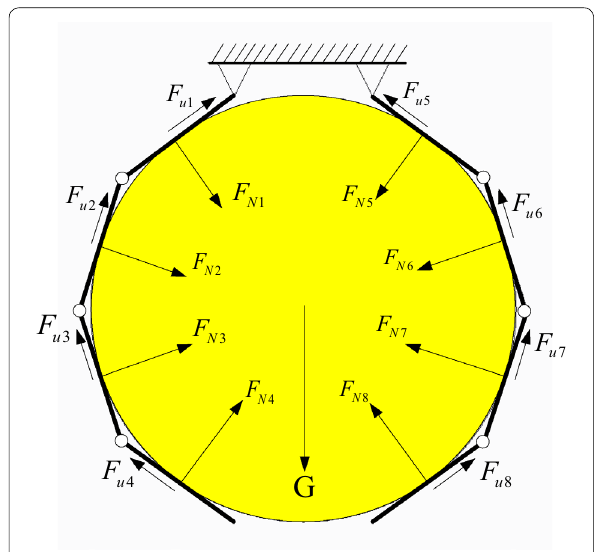
Figure 8 Force analysis of the enveloping